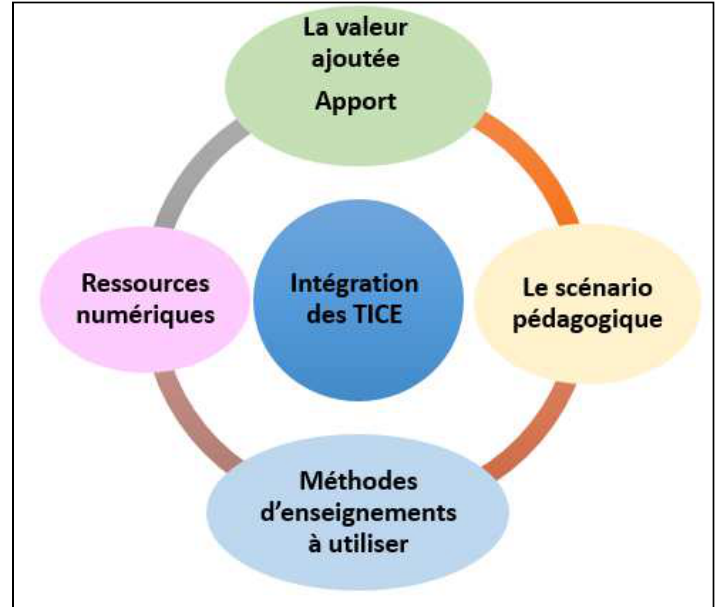
Fig. 1. Planification et intégration des